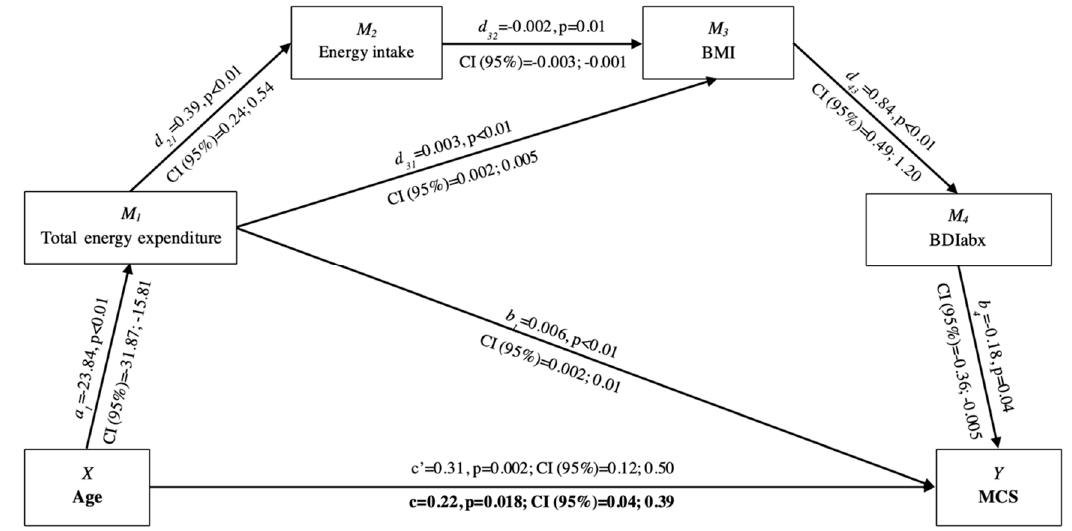
Figure 1. Conceptual and statistical model of age and mediators’ effects on MCS. c’ = direct effect; c = total effect. BMI = body mass index. BDIabx (absolute body dissatisfaction index), MCS = mental component summary.